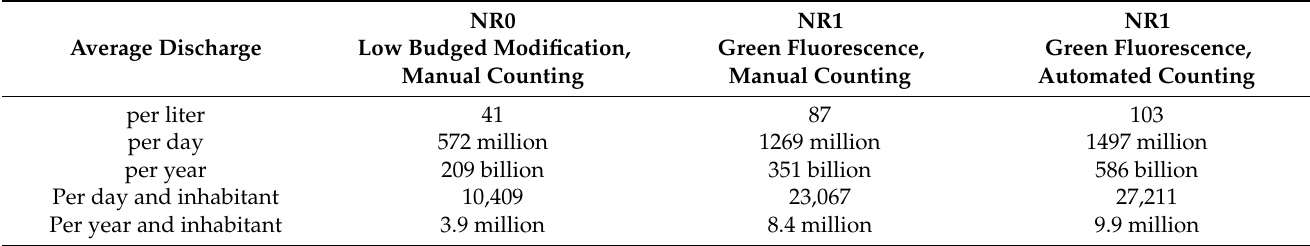
Table 7. Extrapolated results for the improved detection methods. Average values measured with NR0, the low-budged modification of the microscope and manual counting in the long-term mon- itoring of microplastics in the effluent of the WWTP Landau were extrapolated using the linear regressions, as shown in Figure